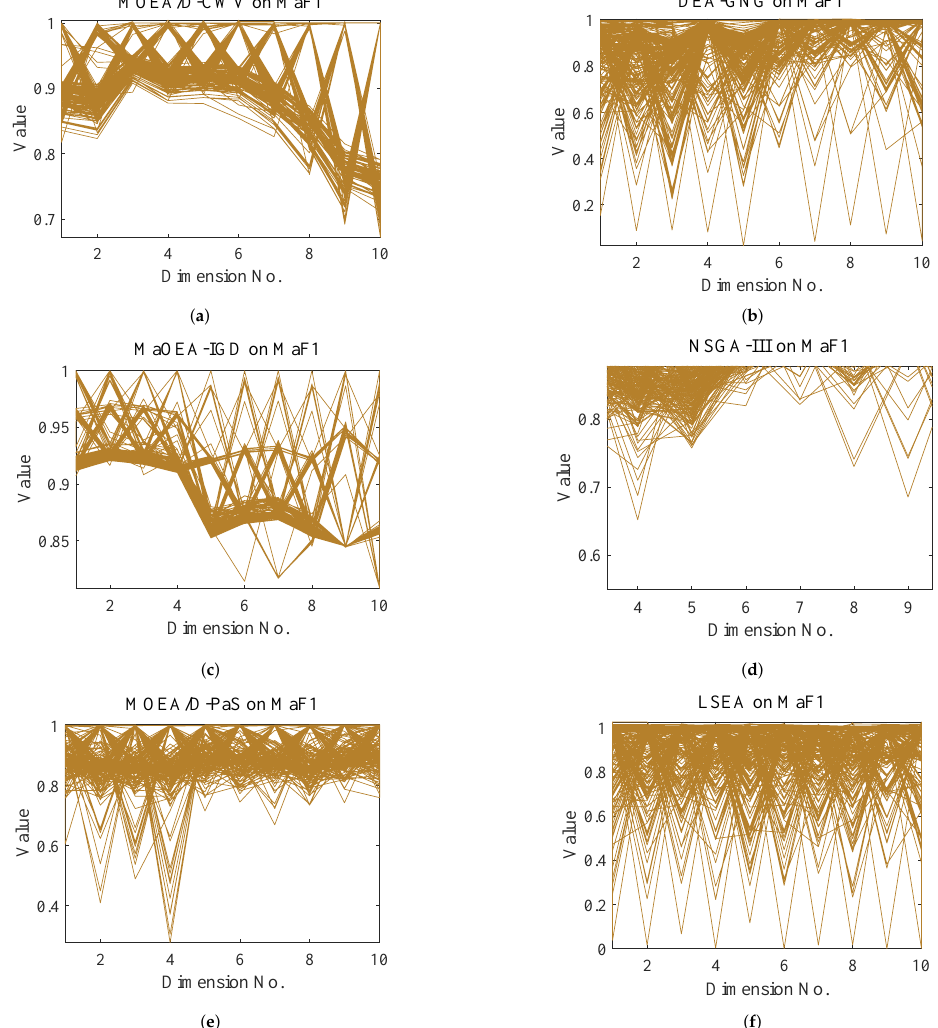
Figure 2. Distributions of populations obtained by the six algorithms in the 10-objective MaF1. ( a ) output population of MaOEA-IGD, ( b ) output population of DEA-GNG, ( c ) output population of MaOEA-IGD, ( d ) output population of NSGA-III, ( e ) output population of MOEA/D-PaS, ( f ) output population of